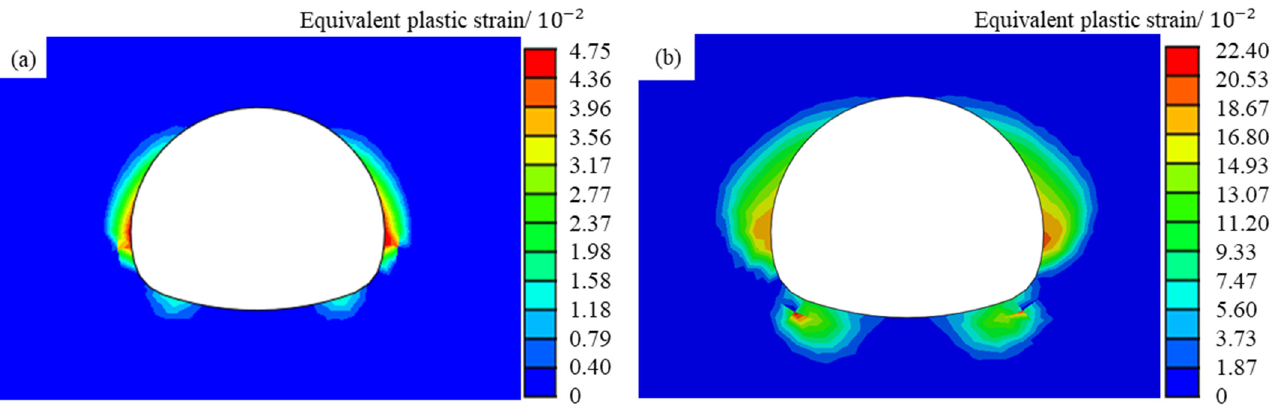
Figure 18. Plastic zone nephogram of surrounding rock after excavation: ( a ) non-softening; ( b ) dual softening.